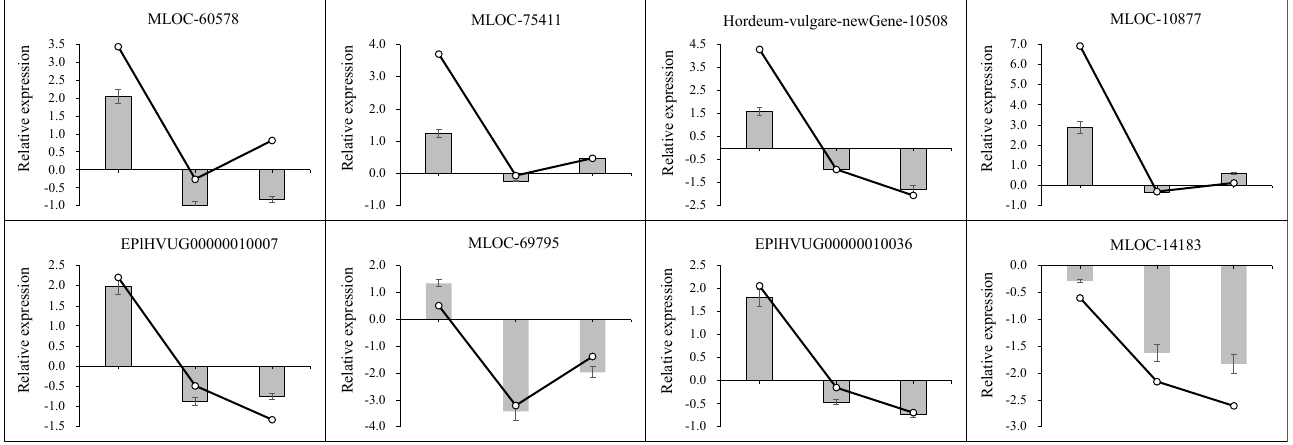
Figure 1. The qRT-PCR validation of eight differentially expressed genes. The bars represent SD (n = 3). The columns indicate relative expression by the qRT-PCR and solid lines by the RNA-seq. From left to right: XZ153, XZ141, and ZD9.